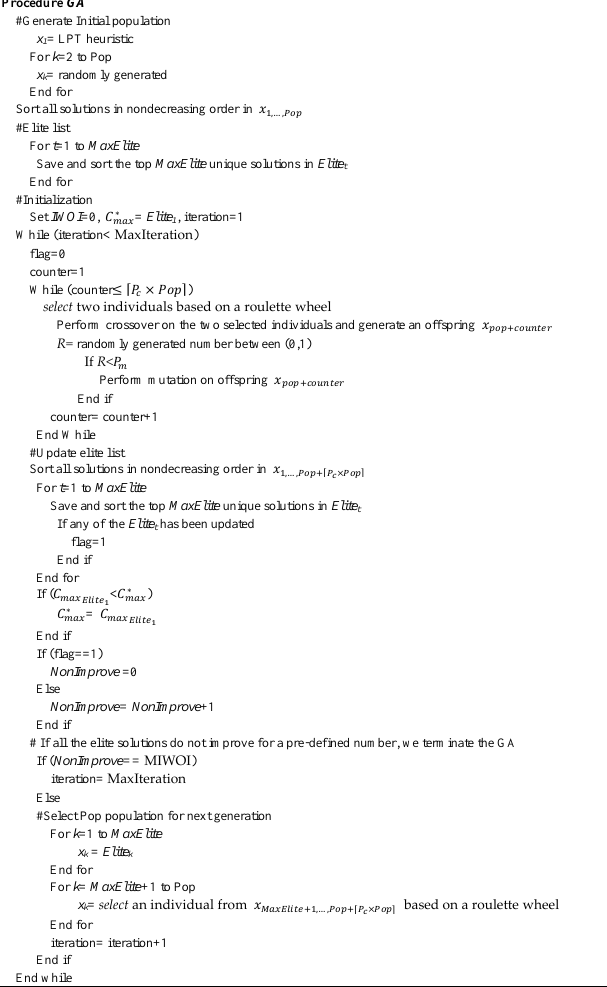
Figure 6. A search procedure for the proposed GA.